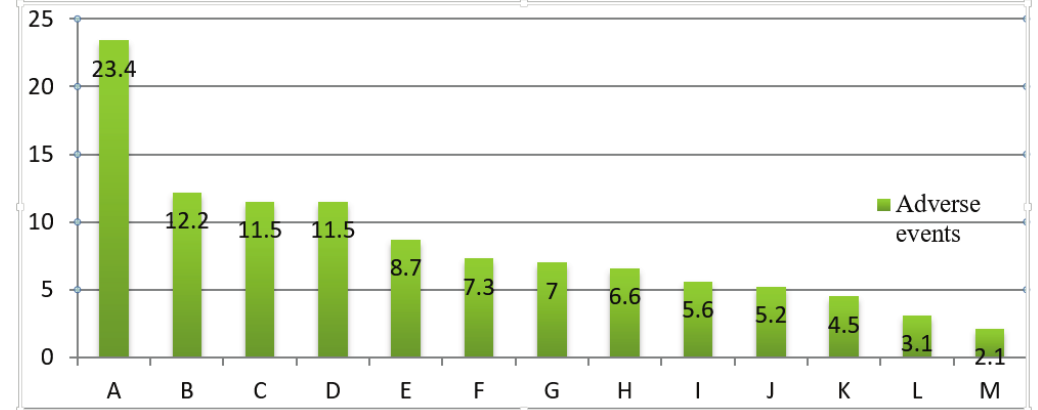
Figure 1: Common ADR seen in TC users in selected pharmacies and cosmetic shops of Addis Ababa, February